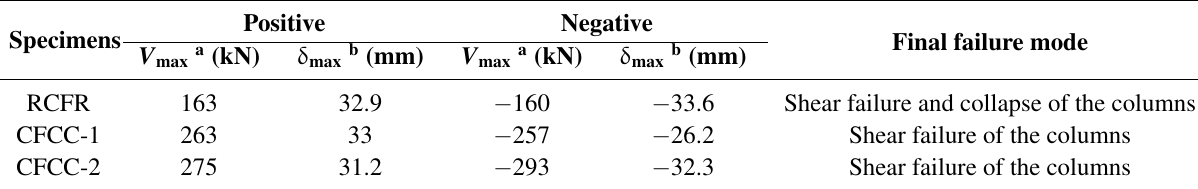
Table 6. The maximum strengths and drifts of the